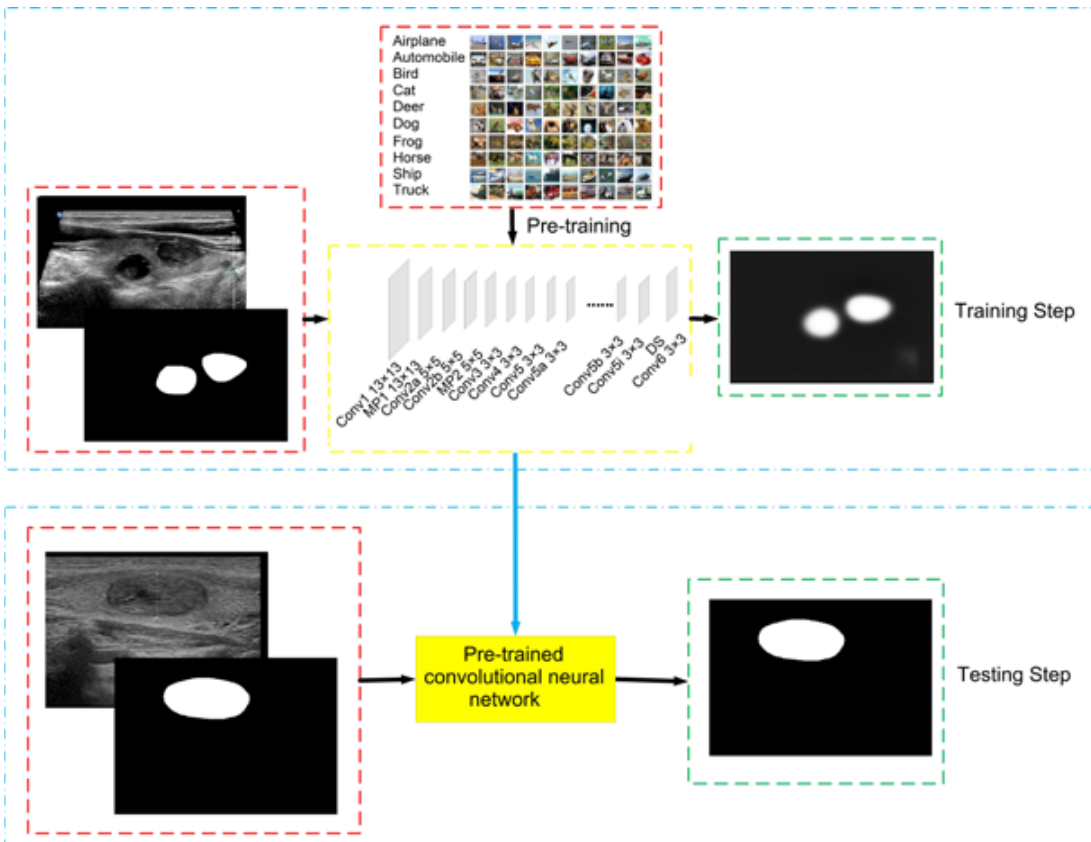
Figure 4 A framework of our convolutional neural network approach, which is first pre-trained with ImageNet database. Then the pre-trained convolutional neural network model takes two-dimensional ultrasound images as inputs and generates segmentation probability maps of